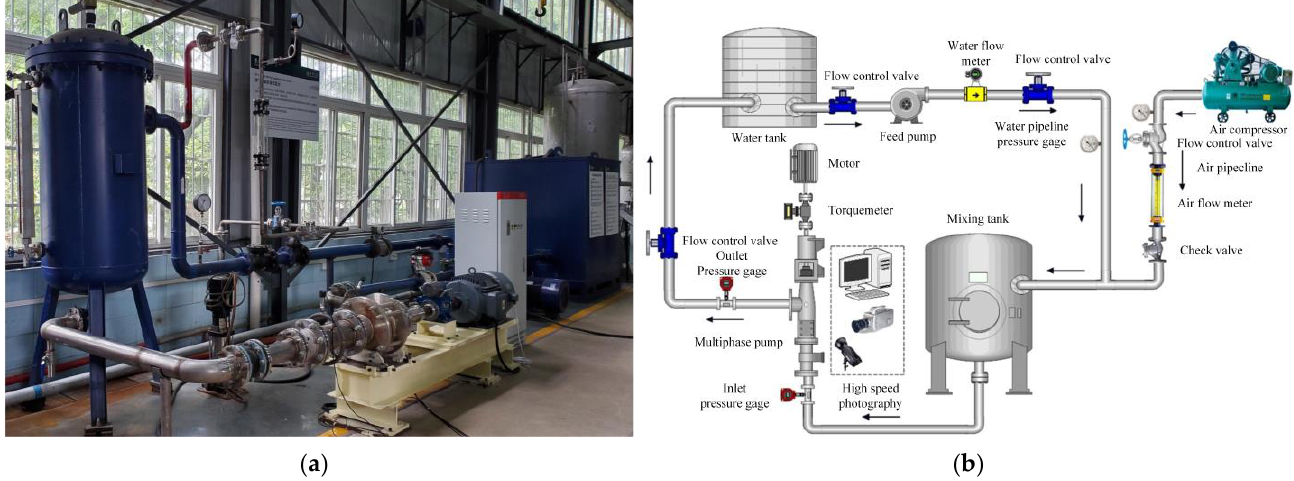
Figure 4. Test system of the multiphase equipment. ( a ) Photograph of the test system and ( b ) schematic of the test system.